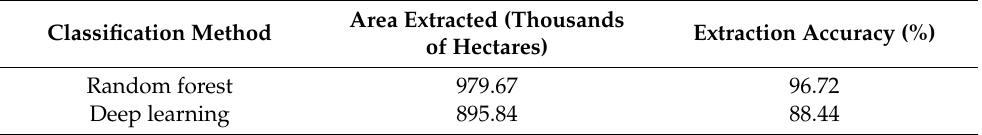
Table 5. Area of winter wheat extracted and extraction accuracy.